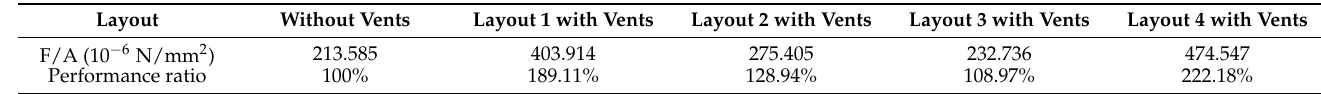
Table 4. Performance improvement with exhaust vents (quad-vortex grippers, configuration 5, L = 4/3 D 3 , A = 2103.22 mm 2